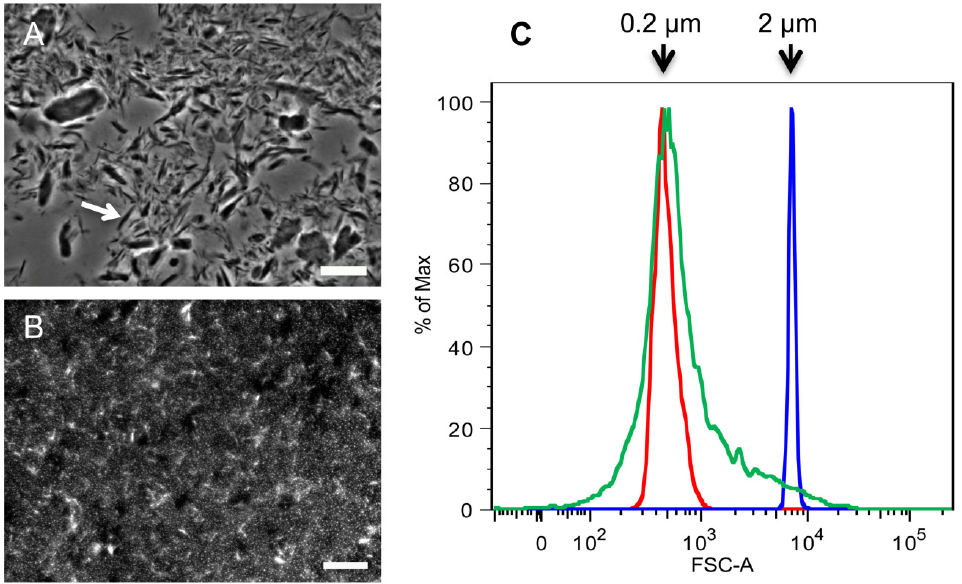
( A ) points to a spike-shaped chitin particle. Bars, 10